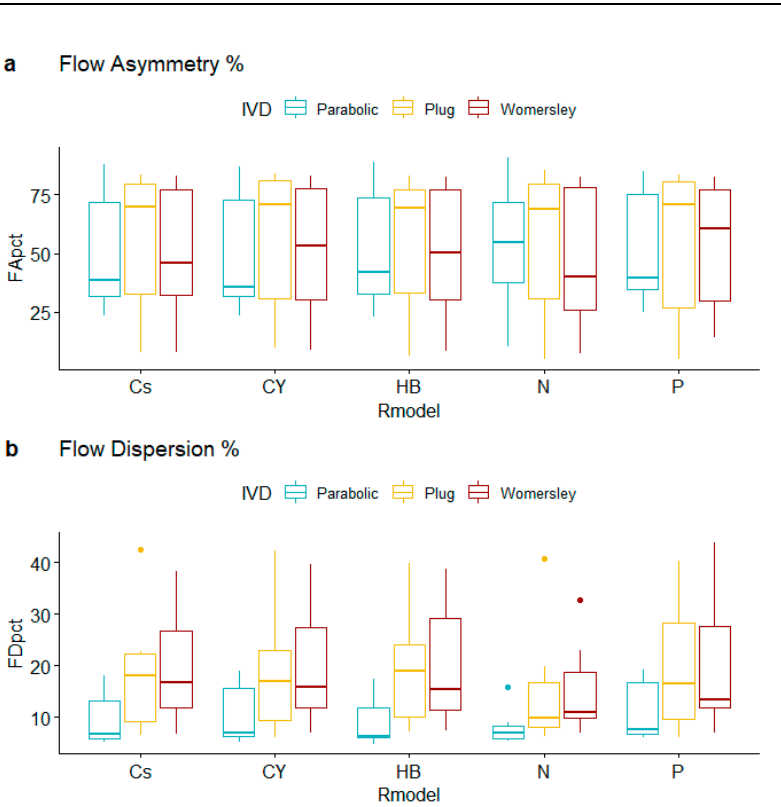
Figure 5. Flow asymmetry and dispersion boxplots for alternative rheological models and inlet velocity distributions.